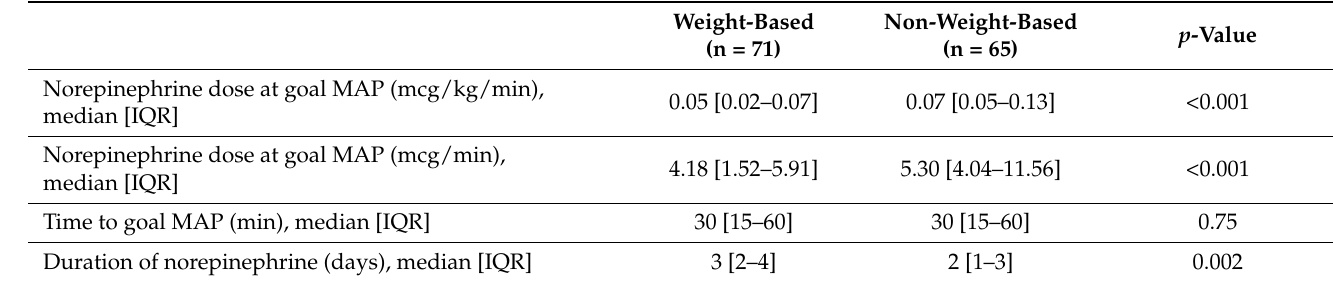
Table 2. Results of Patients who Achieved the Mean Arterial Pressure Goal.